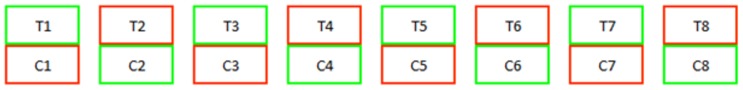
Balanced Block experimental design.